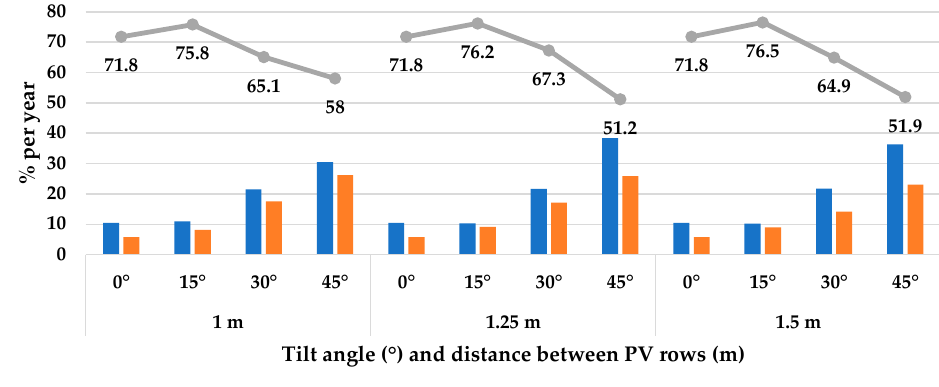
Figure 4. Comparison between shading effects and performance ratios for different tilt angles and distances between PV rows.